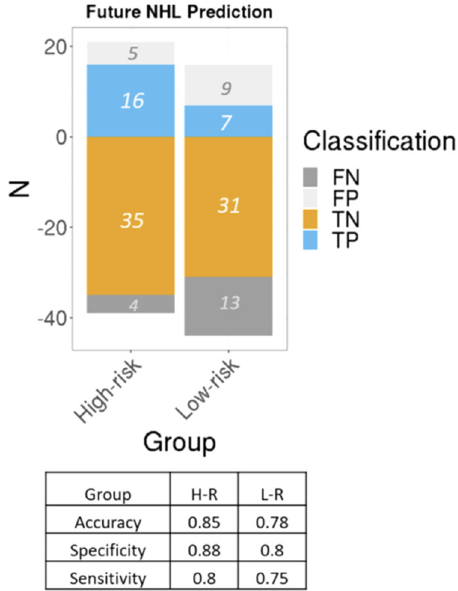
Fig. 3 Performance of the predictive models using the bulk DNA methylation. Numbers are expressed in percentage and refer to the samples from the test set of the prospective